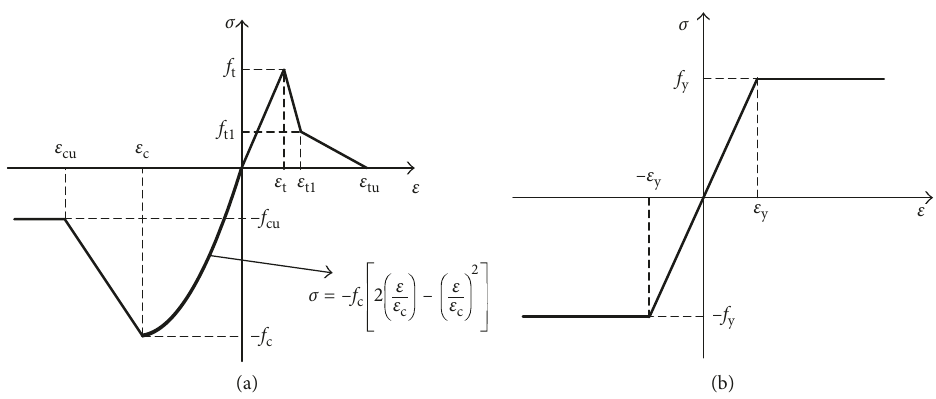
Figure 1: Uniaxial stress-strain relationship of (a) the concrete and (b) steel in this